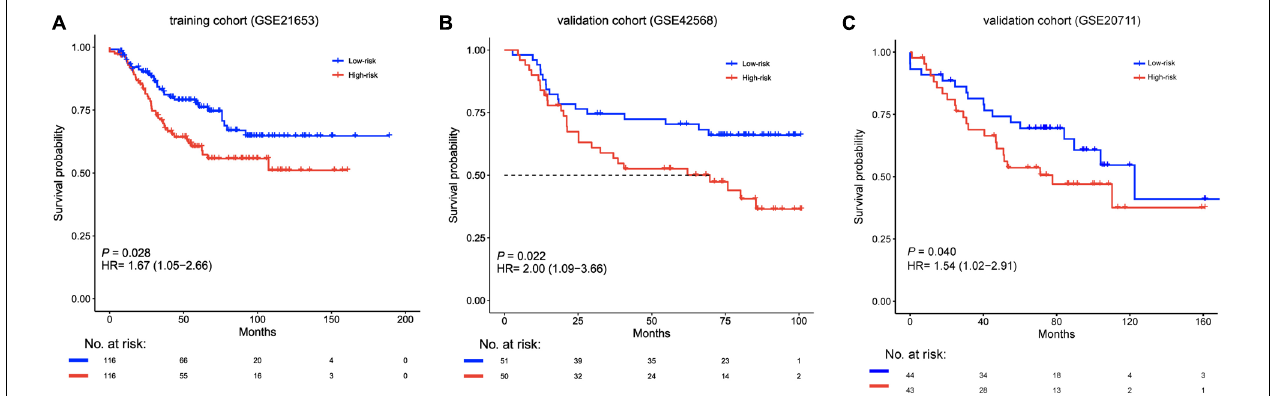
FIGURE 2 | Kaplan–Meier survival curves of disease-free survival between high-risk (red) and low-risk (blue) patients in the (A) training cohort (GSE21653, n = 232), and the (B,C) validation cohort (GSE42568, n = 101; GSE20711, n = 87). The differences between the two curves were determined by the two-sided log-rank test. The number of patients at risk is listed below the survival curves. HR, hazard ratio.